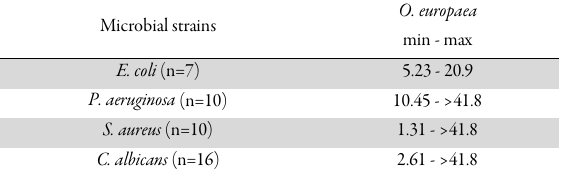
Table 2. MBEC values (mg/ml) Microbial strains